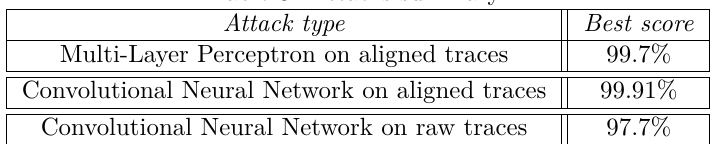
Table 3: Attacks